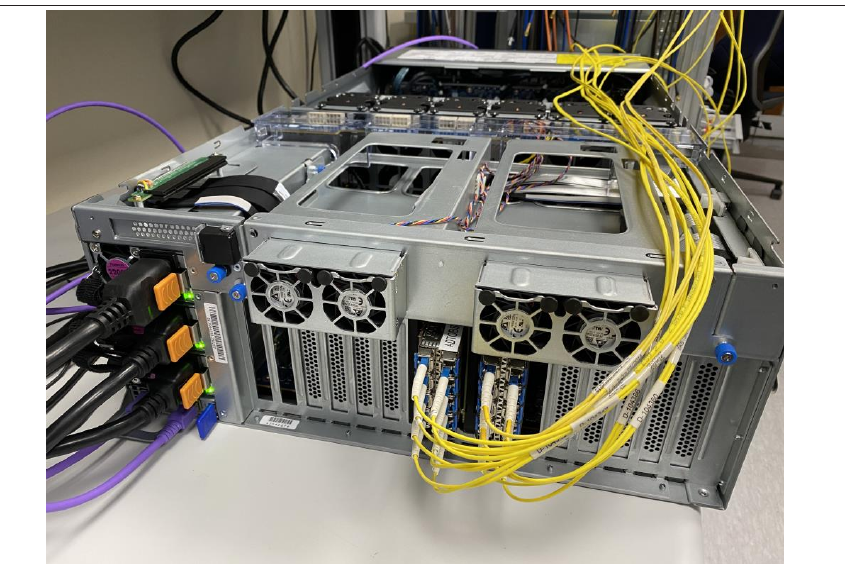
Figure 2. GIGABYTE G481-HA0 with I / O card and connected